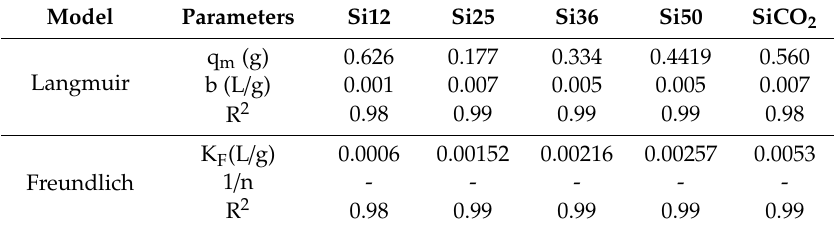
Table 5. CO 2 adsorption capacities obtained at di ff erent